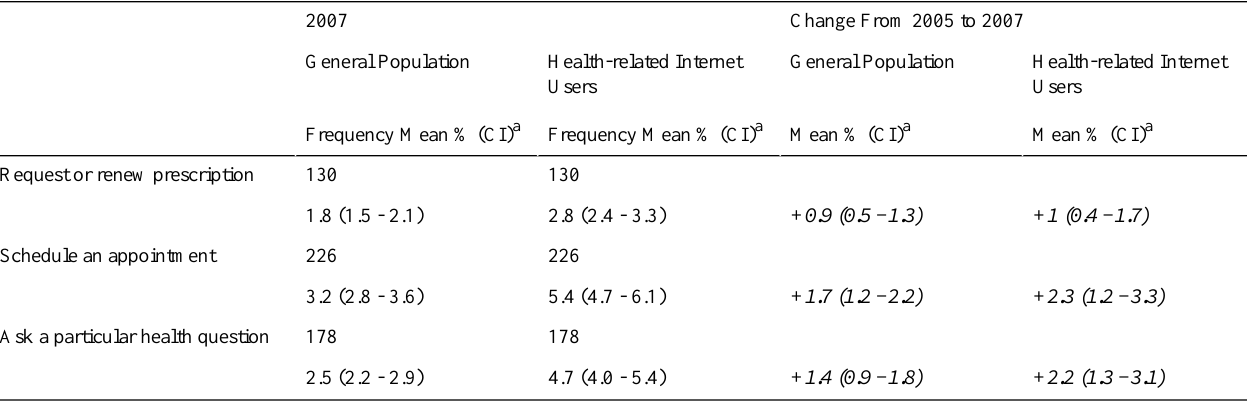
Table 1. Patterns of use of the Internet to communicate with known health professional